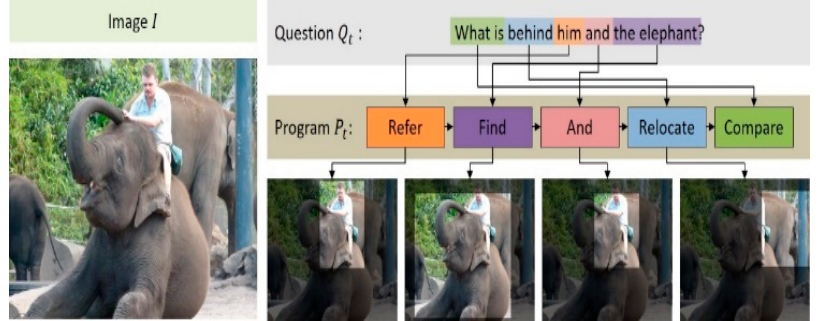
Figure 5. Example of a generated neural program.